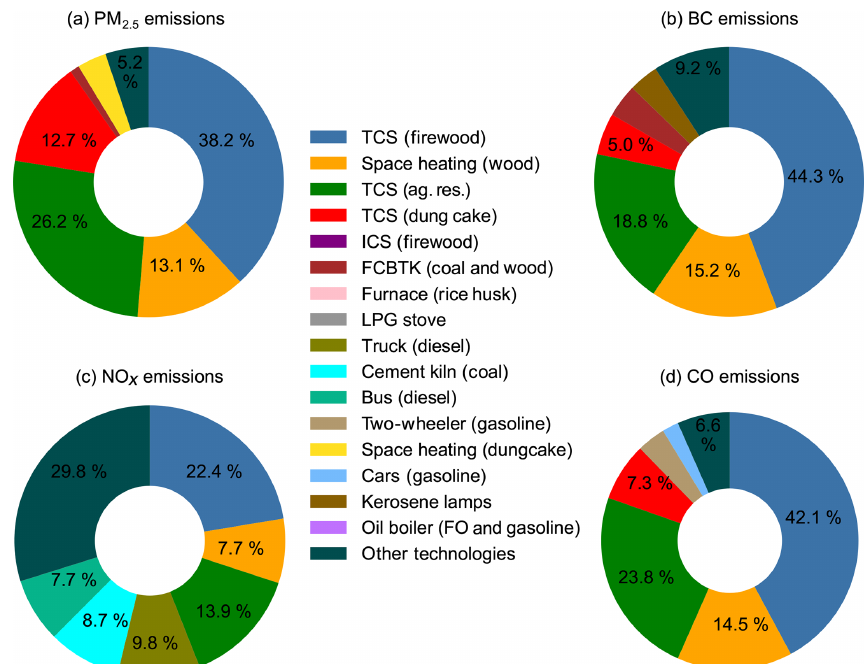
Figure 6. Top six polluting technologies contributing to (a) PM 2 . 5 , (b) BC, (c) NO x and (d) CO